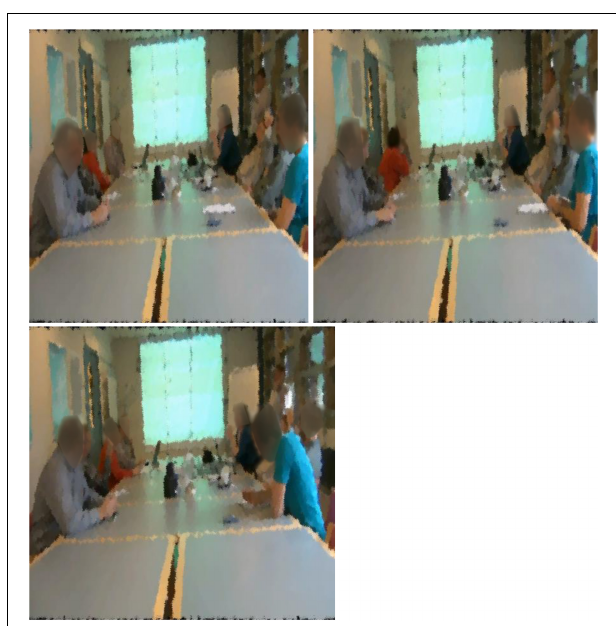
FIGURE 3 | Three sequences from the video